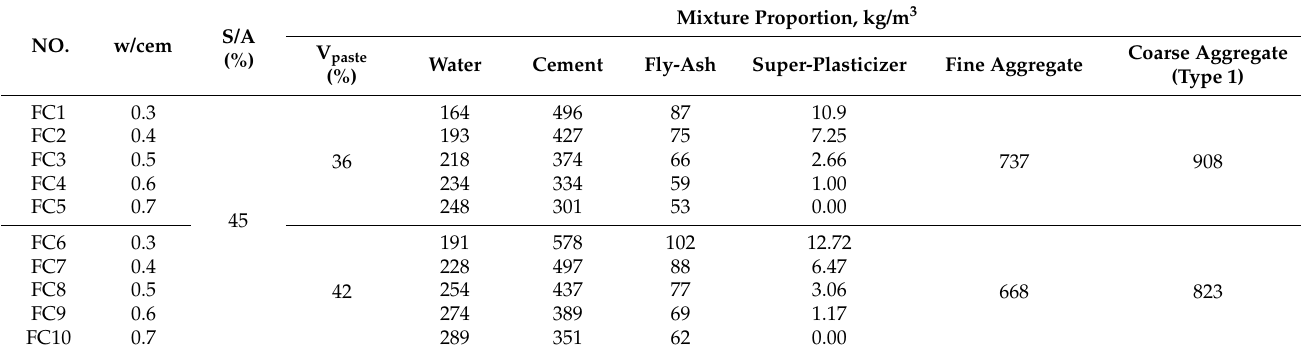
Table 3. Mixture proportions of various levels of fly ash concrete paste content.